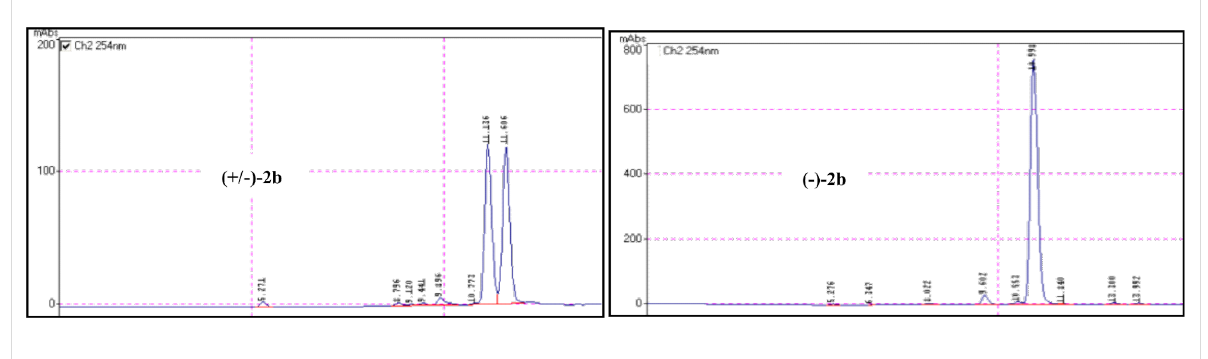
Figure 1: Chiral HPLC analysis: Chiralpak AD-H; n -hexane/2-propanol 99:1 (0.6 mL/min), T = 25 °C; UV–vis detection at λ = 254 nm; retention times: (+/ − ) -2 (11.13 and 11.60 min) and ( − ) -2b (10.99 min).